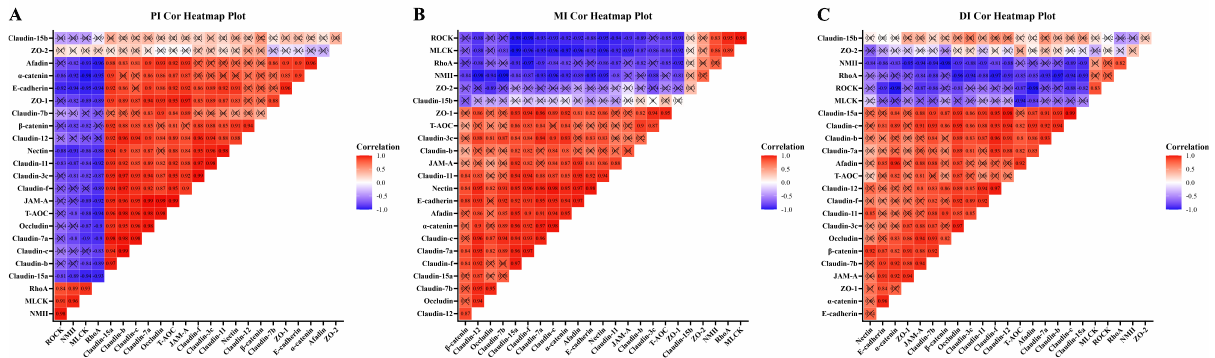
Figure 5. Correlation analysis of parameters in the three intestinal segments of grass carp after infection of Aeromonas hydrophila. ( A ) proximal intestine; ( B ) middle intestine; ( C ) distal intestine. R > 0.7, strong correlation; 0.5 < R < 0.7, moderate correlation; R < 0.5, weak